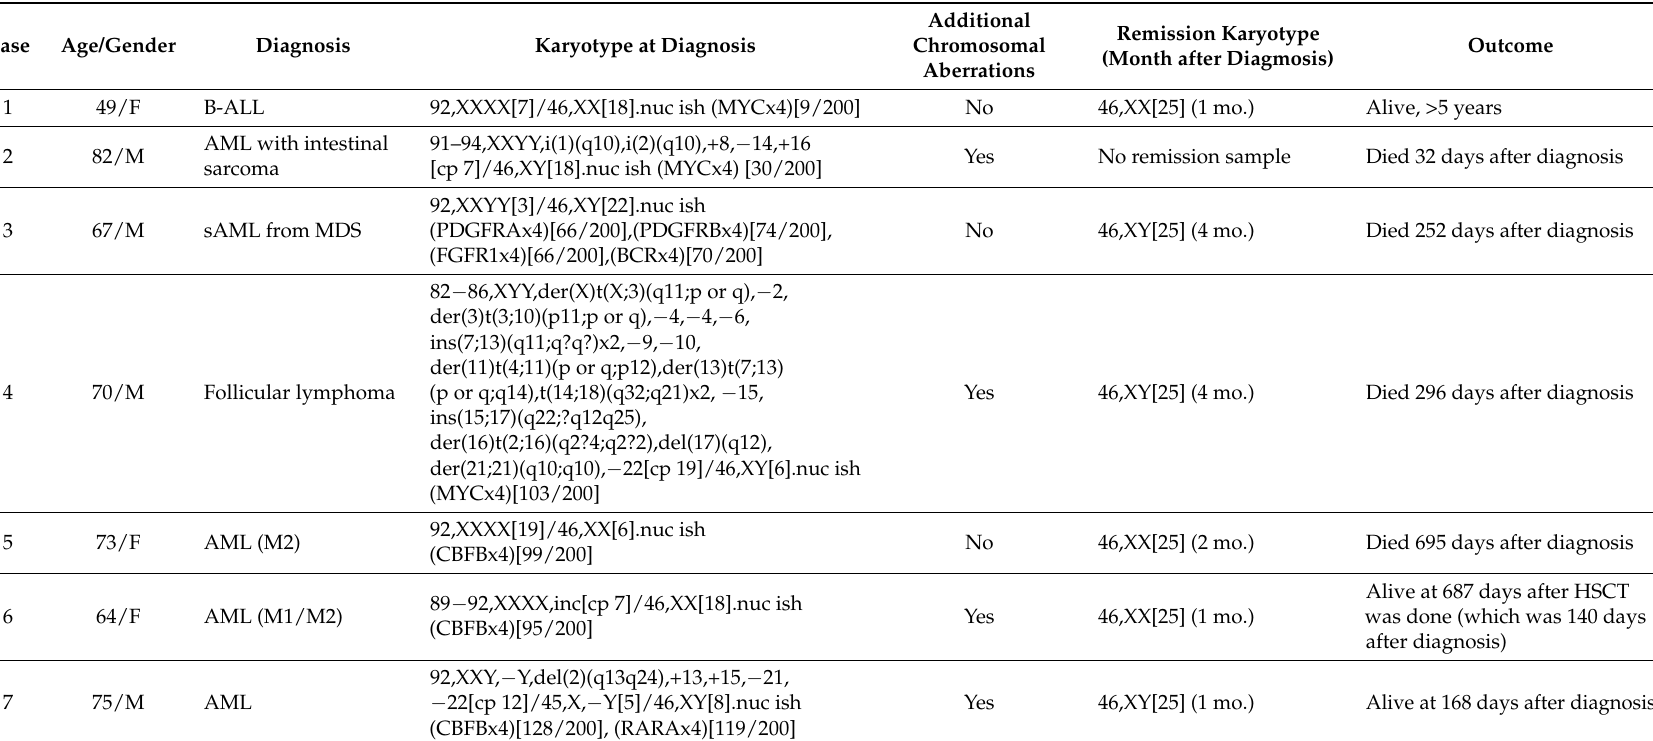
Table 1. Summary of cytogenetic findings in patients with tetraploid/near-tetraploid (T/NT)